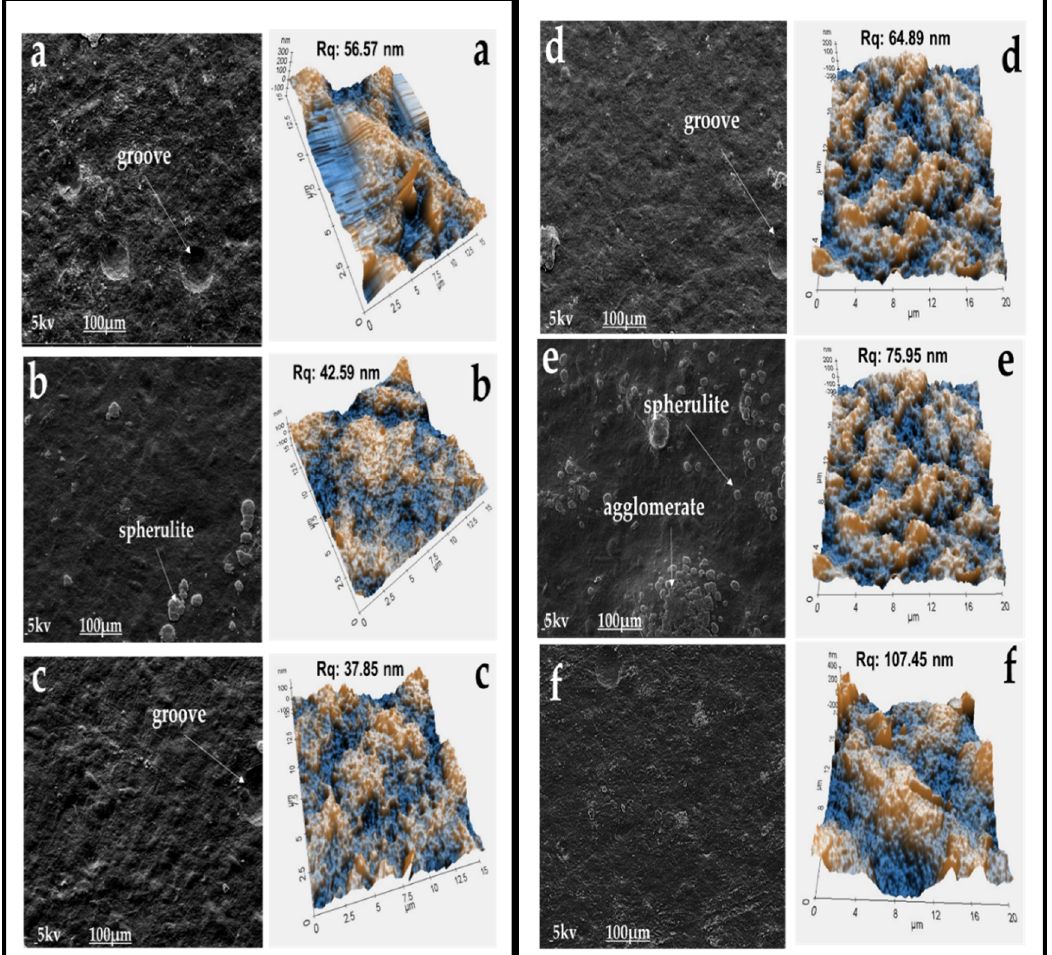
Figure 2. The surface morphologies by scanning electron microscope (SEM) and surface roughness by atomic force microscope (AFM) of irradiated seaweed-neem films ( a ) 0.5, ( b ) 1.5, ( c ) 2.5, ( d ) 3.5, ( e ) 4.5 kGy and (f) control film (non-irradiated), at 1000 times magnification.